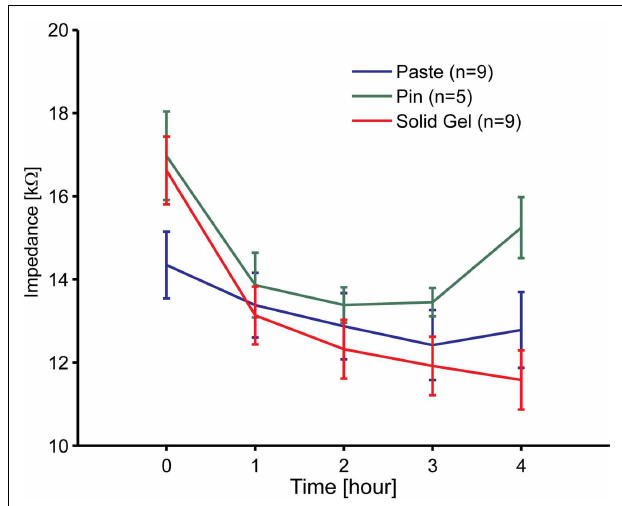
FIGURE 4 |Time course of the electrode impedance of the solid-gel, metal-pin, and conventional paste-based electrodes mounted on the head. Nine participants participated in these experiments at most. However, data for two participants using to the paste-based electrode was omitted, because the values were abnormally high due to drying.